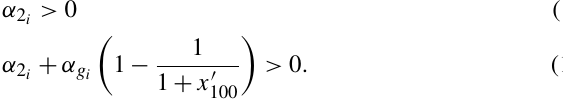
Figure 2. Procedure used to obtain the time series of extreme pre- cipitation and antecedent soil moisture index. The figure shows the daily series of catchment-averaged precipitation for one example station in one example year. The thick dashed magenta line repre- sents the average date of occurrence of annual floods for the ex- ample station, and the two thin dashed lines indicate the window of dates around the average date of occurrence, where extreme (7d maximum) precipitation is selected (blue area). The respective pre- ceding 30d precipitation (green area) is representative of the an- tecedent soil moisture. The procedure is repeated for every year in the period of interest and every hydrometric